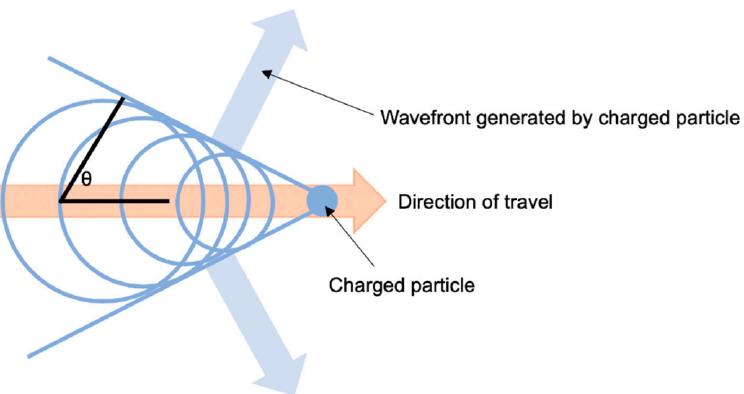
Figure 3. Huygen’s construction of a conical Cherenkov wavefront-a charged particle traveling in a given direction transmits its kinetic energy to the surrounding media, depicted by the larger circles trailing behind the particle. Cherenkov radiation is generated at an angle to the direction of the travelling particle, defined as θ , which is related to the energy of particle [35]. Therefore, the higher the kinetic energy of the particle, the wider the generated wavefront, and hence the more easily the radiation can be